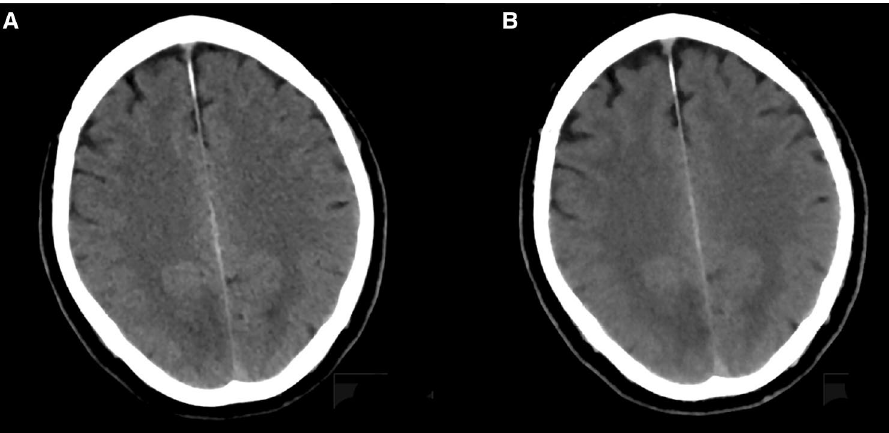
Figure 2. Exemplary patient case with ischemic demarcation (63-year-old male with visual disturbances). ( A ) Axial slices derived from scanning with low dose (LD) using a hybrid reconstruction algorithm (LD_iDose); ( B ) Corresponding axial slices from scanning with LD combined with a model-based iterative image reconstruction algorithm (LD_IMR). The demarcated area (parieto-occipital, right hemisphere) is more markedly depicted in ( B ), corresponding to a higher contrast-to-noise ratio